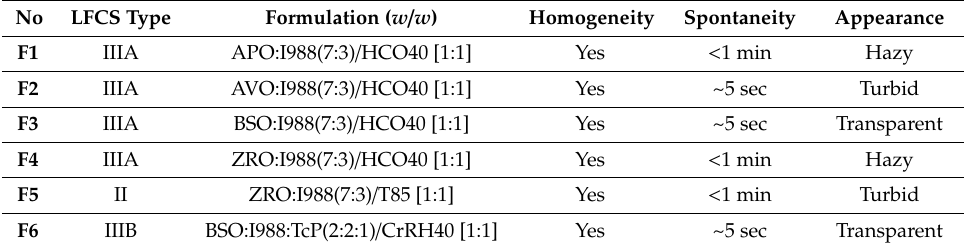
Table 3. Evaluation of drug-free SEDDS / SNEDDS formulations in terms of homogeneity, spontaneity and appearance upon aqueous